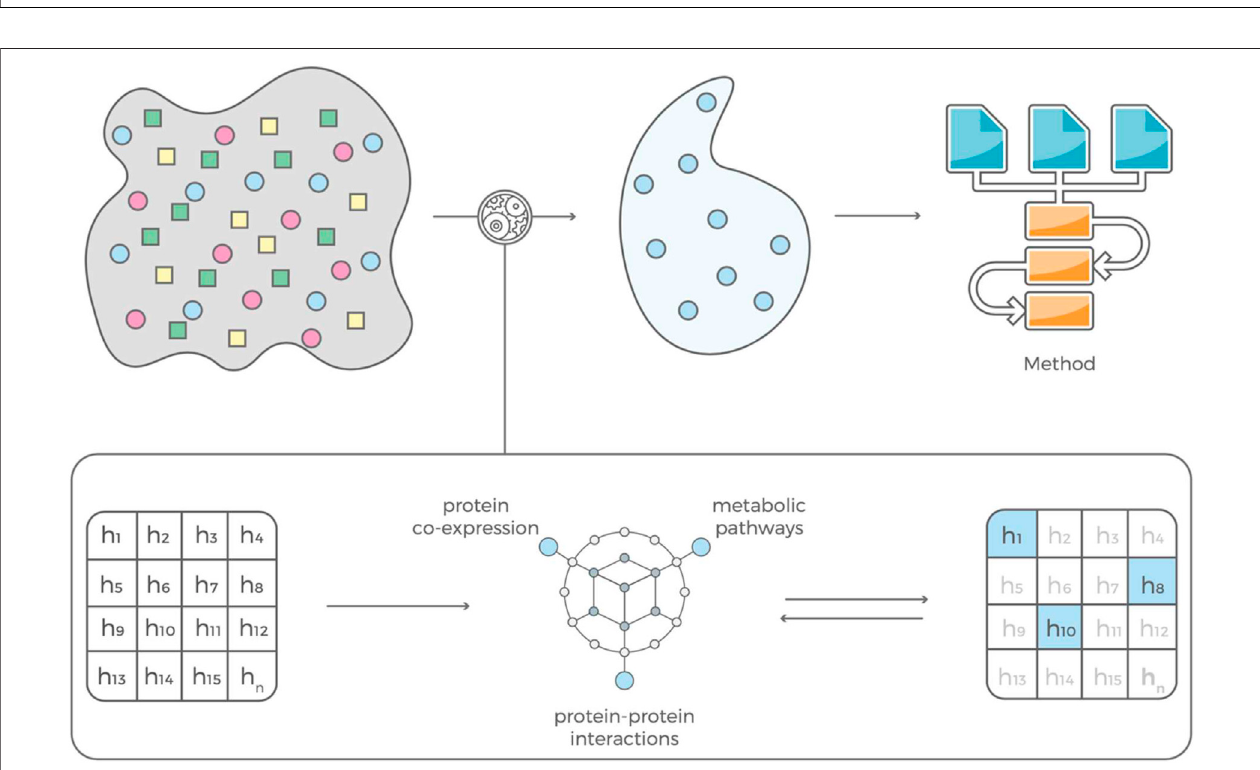
FIGURE 3 | Our feature selection consists of two complementary modules that are in feedback with each other. The contextual module uses information mined from the scienti fi c literature, pathway libraries and protein co-expression data and an evaluation module that estimates predictive power of a feature based on that contextual information. The selected features can be used to build prediction models with standard machine learning algorithms.